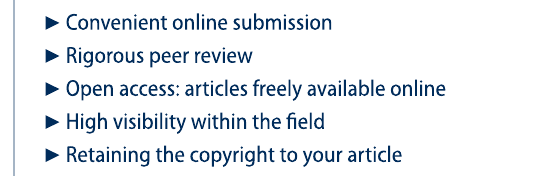
table parameters, using jackknife technique: computational aspects. J Econ Entomol 93:511 – 518 Maia AHN, Pazianotto RAA, Luiz AJB, Prado JSM, Pervez A (2014) Inference on arthropod demographic parameters: computational advances using R. J